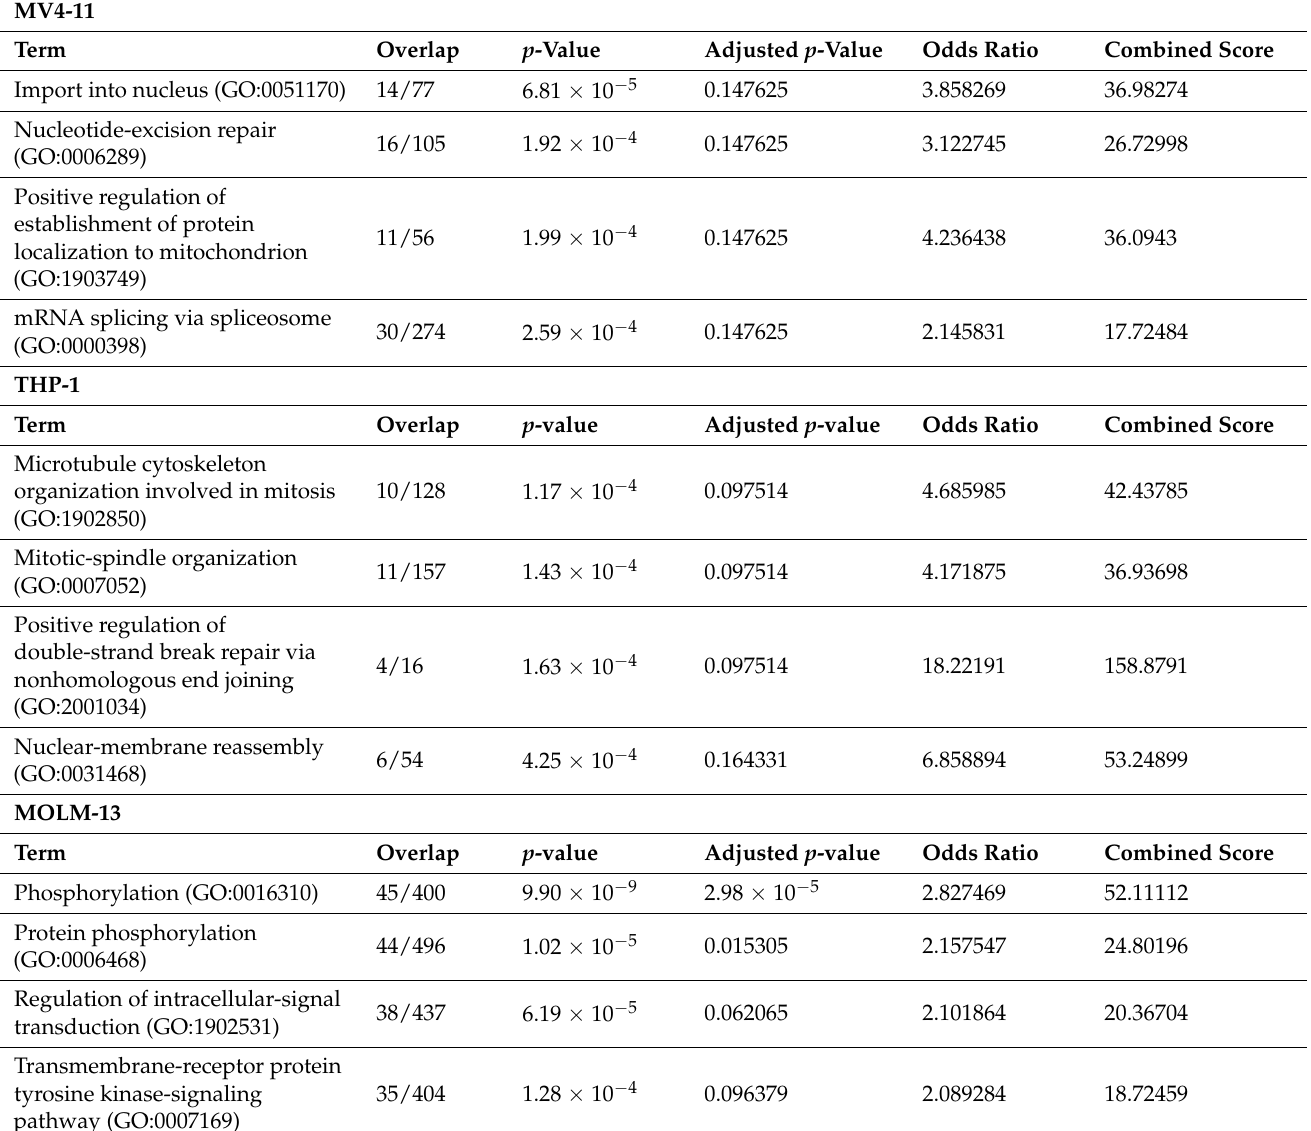
Table 4. GO terms (biological processes) for genes with broadest H3K79me2 domains unique to an AML cell